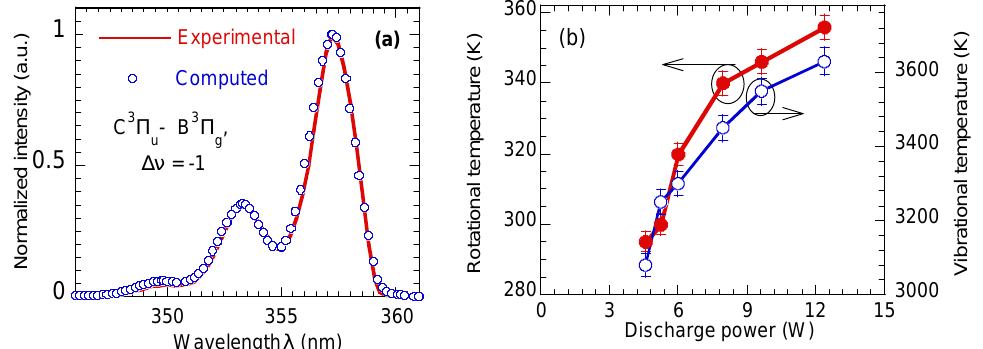
Figure 4. ( a ) Measured and synthetic spectra of the SPS of nitrogen in the spectra range 342–360 nm ( ∆ ν = − 2), for He-H 2 O plasma mixtures; ( b ) Relationship between discharge power and vibrational and rotational temperatures of at fixed gas flow rate.